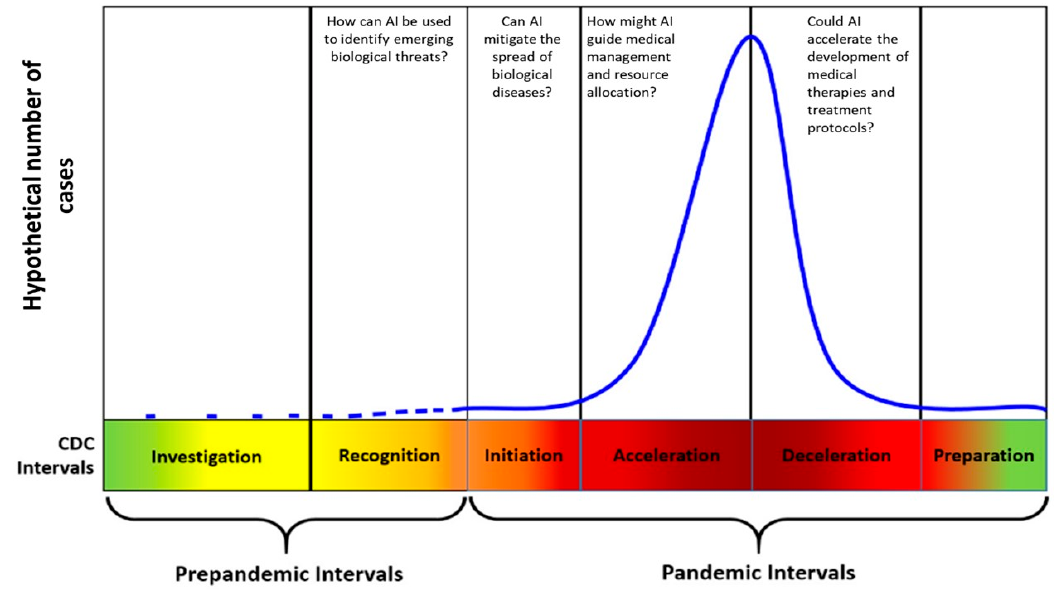
Figure 1. WHO pandemic response phases with distinctive AI applications.